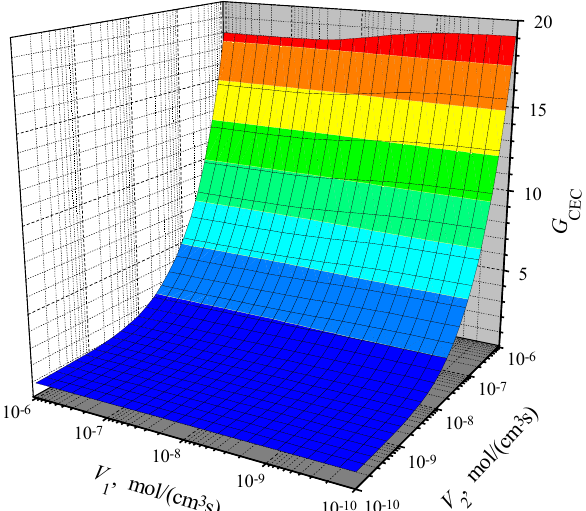
versus the maximal enzymatic rates V CEC